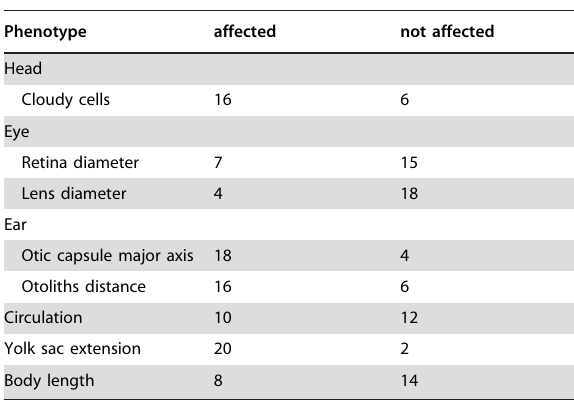
Table 1. Summary of Phenotypes at About 25 hpf .. ... .... ... ... .... ... ... .... ... ... .... ... ... .... ... ... .... ... ... .... .